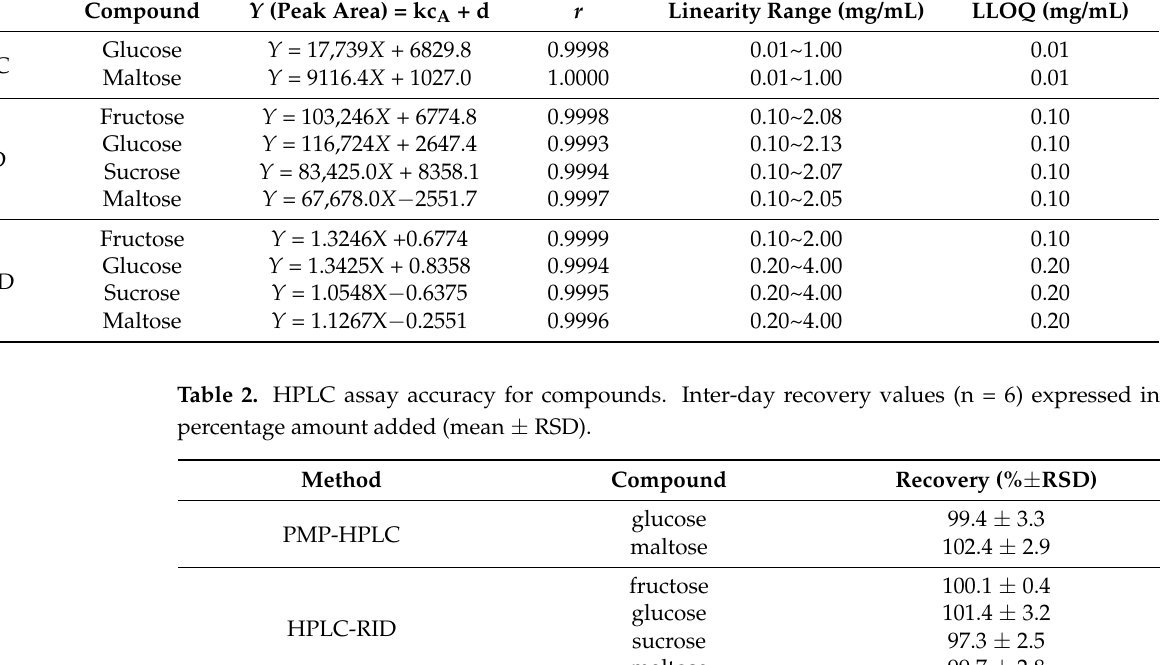
Table 1. HPLC-based calibration function parameters for compounds, including regression equations, correlation coefficients ( r ) and linearity range.